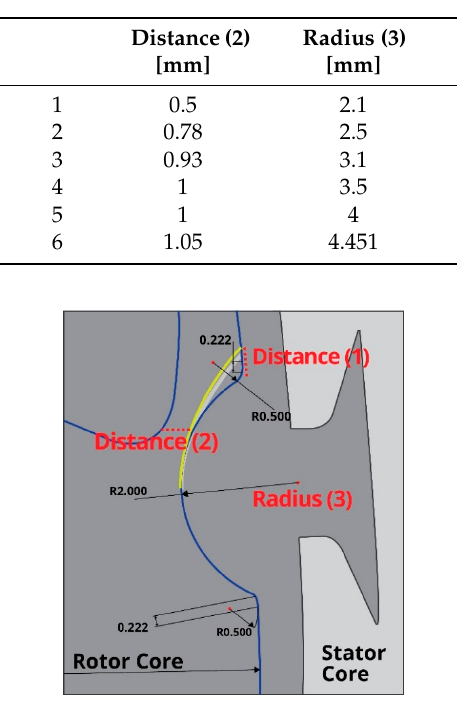
Figure 10. Comparative analysis of torque ripple when notch shape distance (1) is 0.5 mm. 4. Discussion In this study, a finite element method was used to analyze the properties of interior permanent magnet synchronous motors that are used as drive motors in electric cars. The external diameters of the stator and the rotor were set to be the same in order to compare various parameters such as the cogging torque, torque ripple, and back electromotive force voltage according to the position of a notch on the rotor shape. In the electromagnetic field analysis, the input voltage and input current were set to be the same. The motor’s performance characteristics were analyzed according to the notch position on the rotor shape. The aim of this work was to determine an approach to obtain the design a rotor shape that can minimize the cogging torque and torque ripple so that a low-noise drive motor can be designed. The application target was an IPM motor; thus, current phase angle control was required to ensure that various characteristics of the motor, such as efficiency, power, and torque, do not degrade. Therefore, the point with the maximum torque was found via phase angle control, and the torque ripple, cogging torque, and maximum power were determined. First, the notch position on the rotor shape was analyzed. Notches can be placed in a variety of positions, and thus, to determine the optimum position, notches were placed in five locations on the